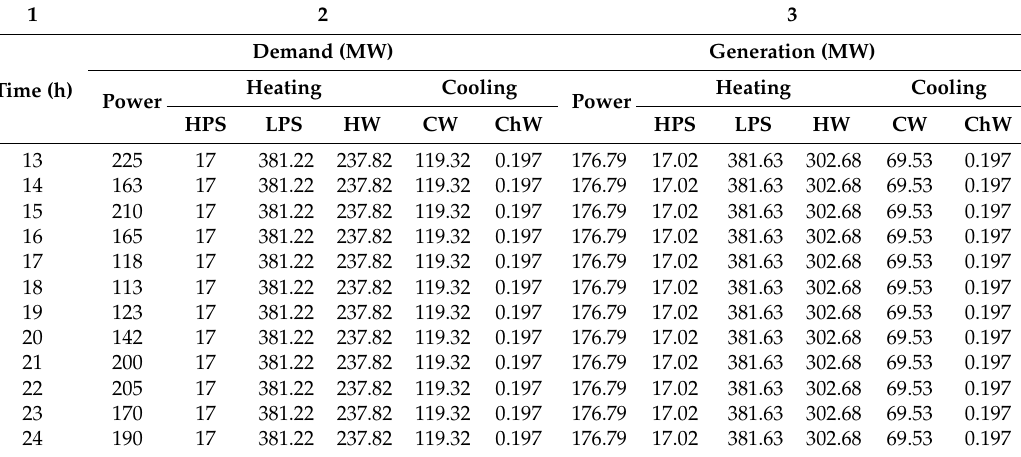
Table A10. TriGenSCA after iteration from 13 to 24 h.